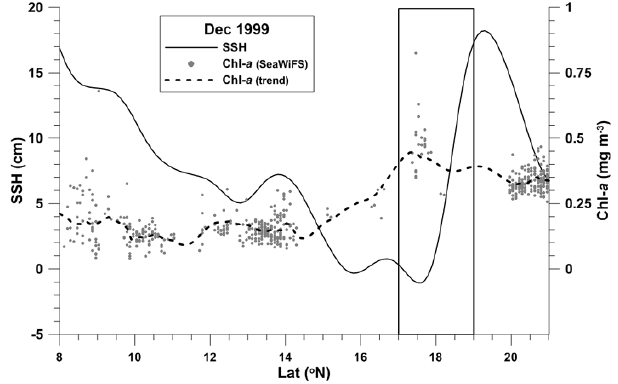
Fig. 14. The zonal average of monthly sea surface height (SSH) within the meridional band between 115 ◦ E and 117 ◦ E (See Fig. 1) in December 1999 and monthly data of sea surface Chl a concen- tration from SeaWiFS observed at all pixels within the band in the same month. The dashed curve is the zonal average of spatially in- terpolated Chl a data within the band. The rectangle indicates the position of the study area, i.e. within ± 1 ◦ of the SEATS station. The maximum Chl a corresponded to the minimum of SSH, suggesting that a cyclonic eddy was responsible for the local Chl a